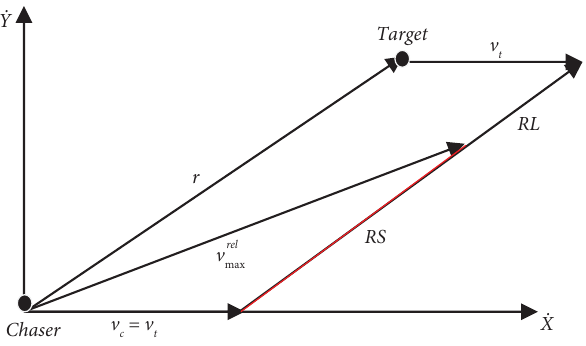
Figure 2: Construction of rendezvous set (RS).